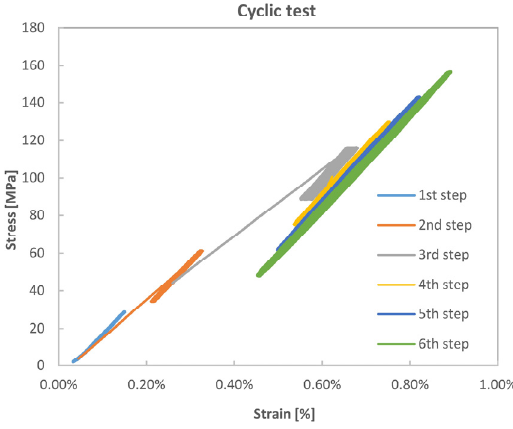
Figure 8. Tensile stress vs. strain curve with application of six step cycling loads. Table 4. Values of load steps.